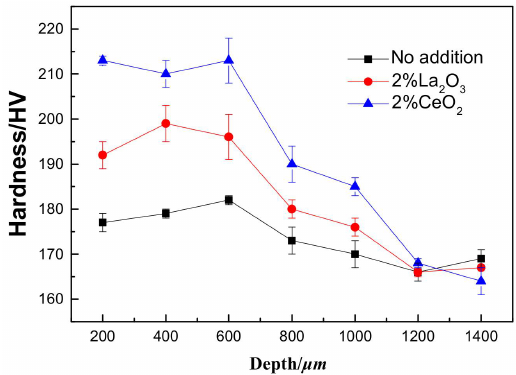
Figure 5. The hardness measurements of the laser-cladded 316L stainless steel with or without the modification of rare earth oxides from the laser-cladding coating zone to the 316L stainless steel substrate zone. The measurement interval was 200 µ